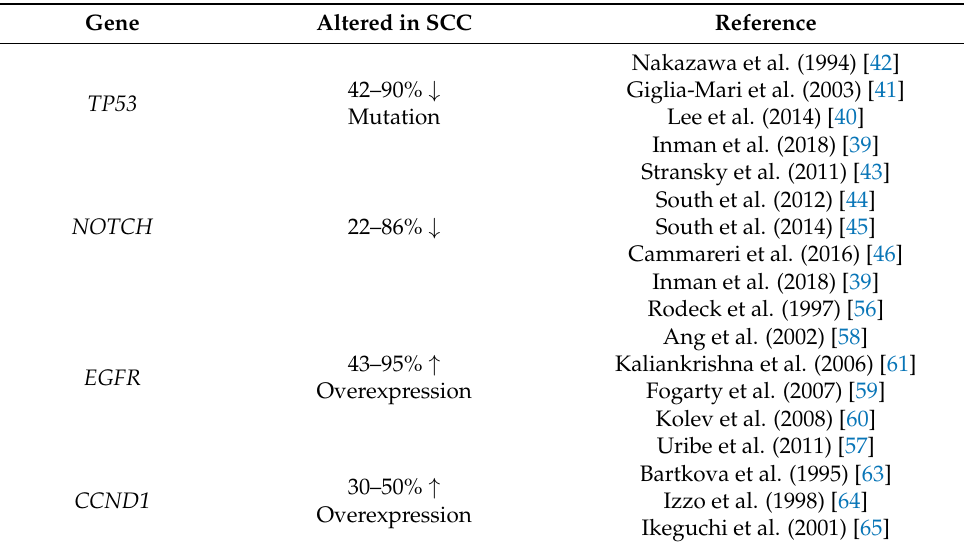
Table 2. Frequently altered genes in squamous cell